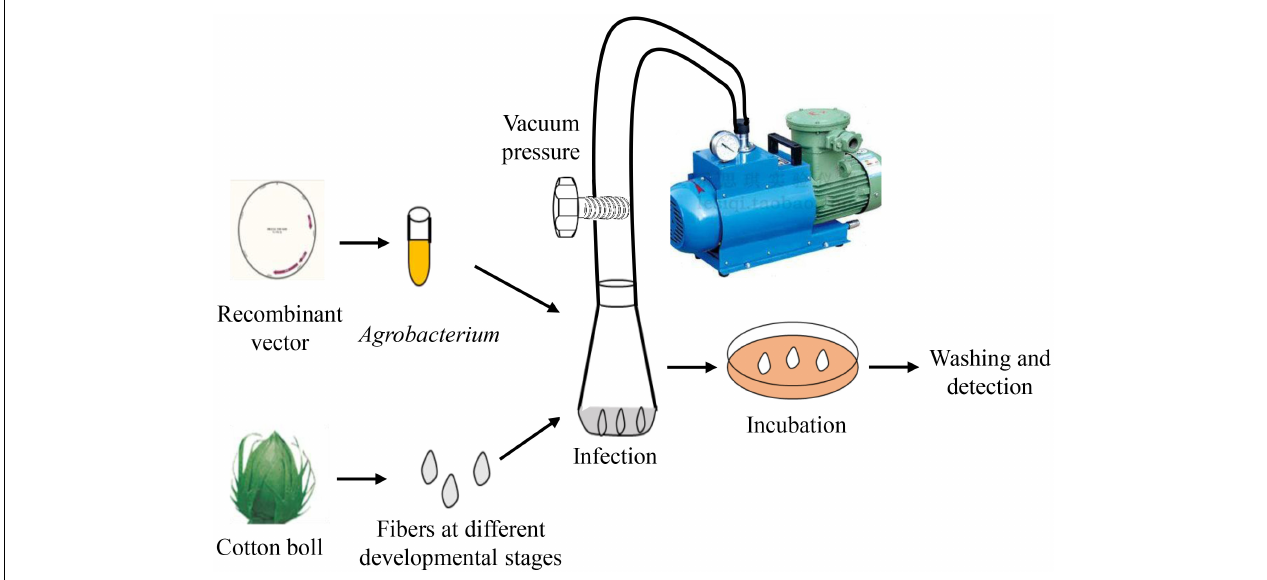
FIGURE 1 | Schematic procedures for Agrobacterium -mediated transient transformation of cotton